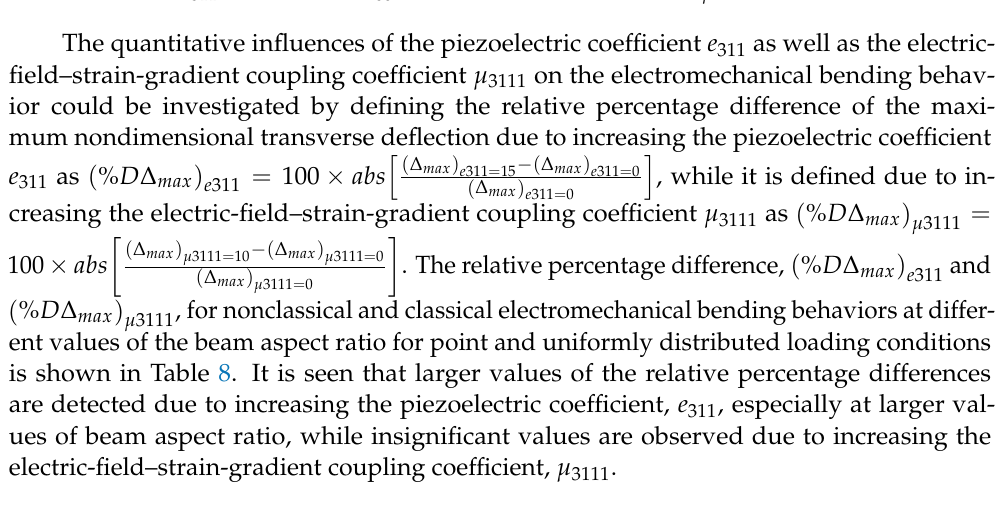
(cid:3032)(cid:3028) = 4 and (cid:3039) = (cid:3035) (cid:3035)